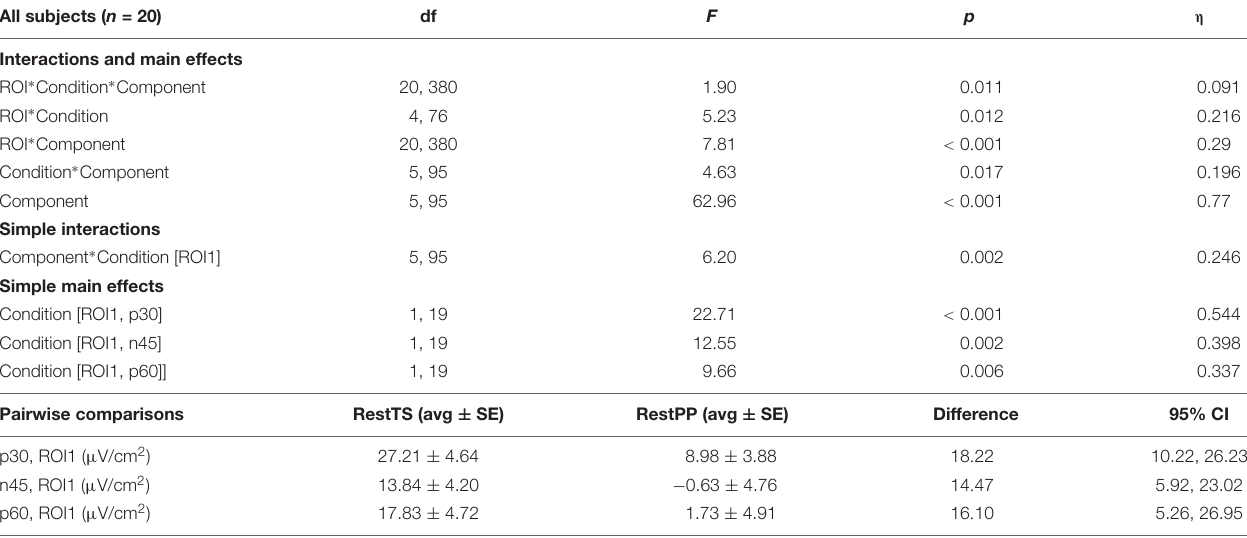
TABLE 1 | SICI related modulation of TEPs amplitude – Three-way ANOVA: significant effects and interactions. All subjects ( n = 20) df